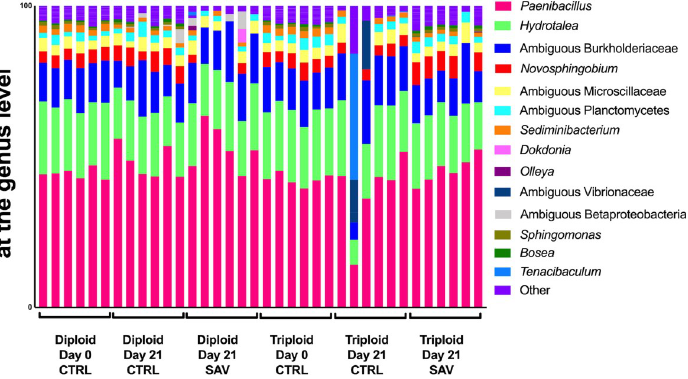
Fig 4. Relative microbial composition in the skin of Atlantic salmon following challenge with SAV3. Relative abundance at the genus level for triploid and diploid skin at day 0, day 21 unchallenged, and day 21 post-immersion in SAV bath